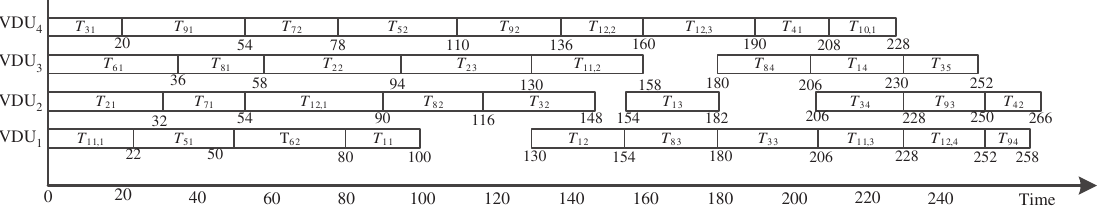
Figure 6: Gantt Chart of RS.